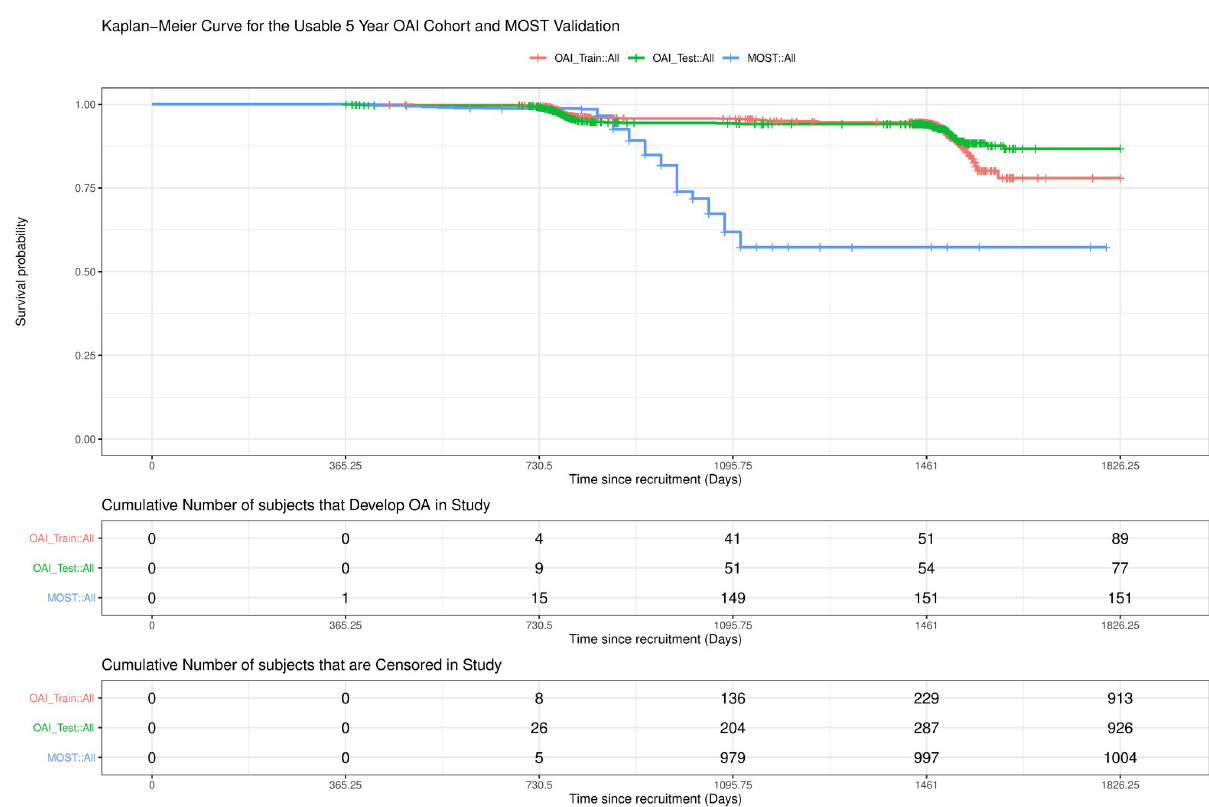
Fig 3. Observational KM curve stratified by sample. The red depicts the OAI training sample and the green shows the OAI test sample. The blue curve is the MOST validation data. The tables below illustrate the way in which the data is split between the samples.